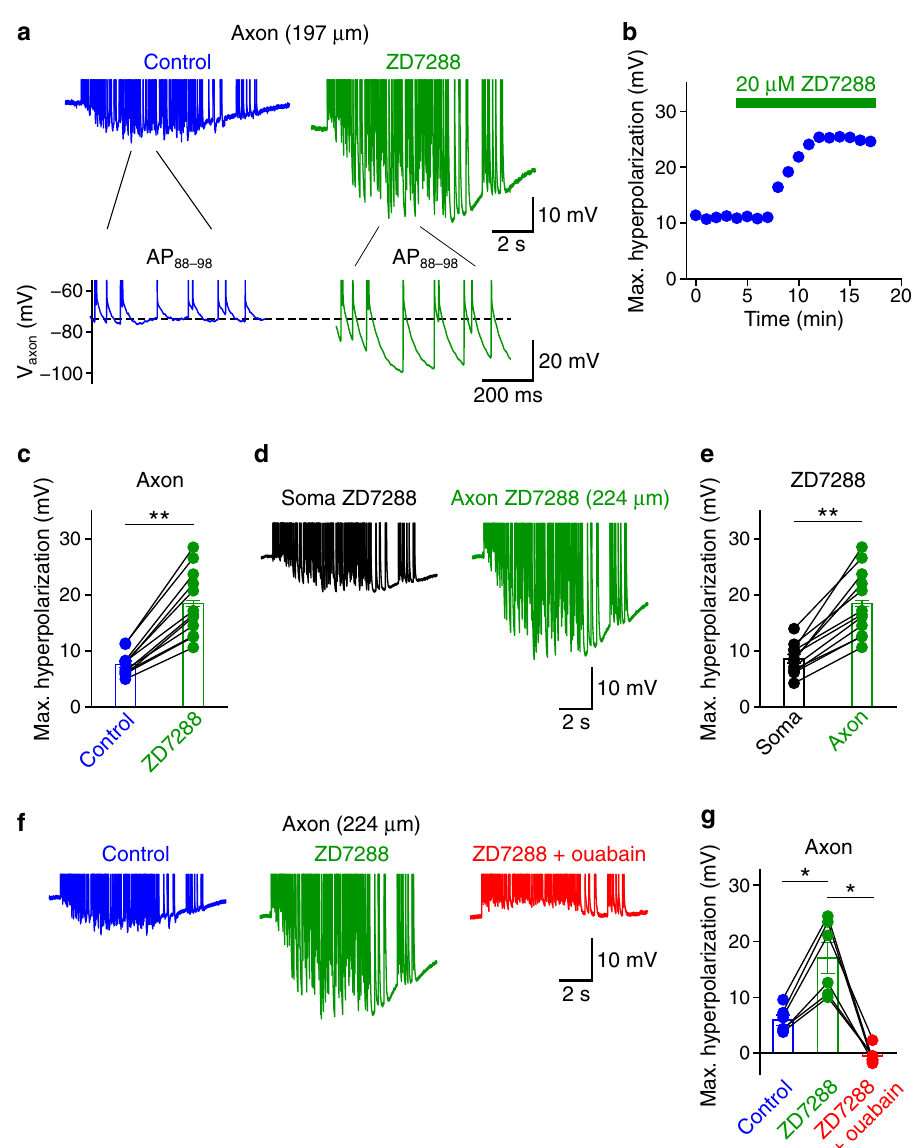
Fig. 5 HCN channels oppose the hyperpolarization created by Na + -K + ATPases in PV + -BC axons. a Top, subthreshold axonal voltage trajectories during the physiologically relevant AP train in control (blue) and 20 µ M ZD7288 (green). Bottom, axon voltage trajectories between the 88th and 98th AP (AP 88 – 98 ) plotted on an expanded time scale. APs in this fi gure were truncated at − 55 mV to highlight hyperpolarizations between APs in ZD7288. To facilitate the comparison with other recordings, we adjusted the baseline axonal membrane potential in control to − 66 mV by injecting a constant hyperpolarizing current of − 19.6 pA into the axon during the soma – axon recording. This holding current was not changed throughout the experiment. b Peak amplitude of the axonal AP-dependent hyperpolarization (Max. hyperpolarization) from the recording in a plotted against experimental time. c Summary graph showing the peak amplitude of the AP-dependent hyperpolarization in PV + -BC axons in control and 20 µ M ZD7288. ** indicates P = 0.0005 ( n = 12 soma – axon recordings, two-sided Wilcoxon signed rank test). d Subthreshold somatic voltage trajectory and corresponding axonal voltage signal in a PV + -BC in 20 µ M ZD7288. e Summary graph comparing the peak amplitude of the AP-dependent hyperpolarization in PV + -BC somata in 20 µ M ZD7288 with that of the corresponding axonal signal. ** indicates P = 0.0005 ( n = 12 soma – axon recordings, two-sided Wilcoxon signed rank test). f Subthreshold axonal voltage trajectory during the physiologically relevant AP pattern in control (blue), 20 µ M ZD7288 (green) and after co-application of 20 µ M ZD7288 and 200 µ M ouabain (red) from a soma – axon recording. g Summary graph showing the peak amplitude of the AP-dependent hyperpolarization in six PV + -BC axons in control, 20 µ M ZD7288 and after co-application of 20 µ M ZD7288 and 200 µ M ouabain. * indicates P = 0.03 (n = 6 soma – axon recordings, two-sided Wilcoxon signed rank test). Axonal voltage traces in d and f are from the same recording. In c , e , and g , data points from the same experiment are connected by lines. Error bars in this fi gure represent ± SEM. Source data are provided as a Source data fi Methods HCN2 subunits 22 . With the high sensitivity of HCN2 subunits to Patch-clamp recordings from PV + -BC axons and dendrites . Experiments on cAMP 52 , neuromodulation of HCN channels in PV + -BC axons Wistar rats were ethically approved by the Norwegian Food Safety Authority may represent a mechanism by which the brain fi ne-tunes the (Mattilsynet) and were performed in strict accordance with institutional, national, magnitude and timing of synaptic inhibition 17 . and European guidelines for animal experimentation.